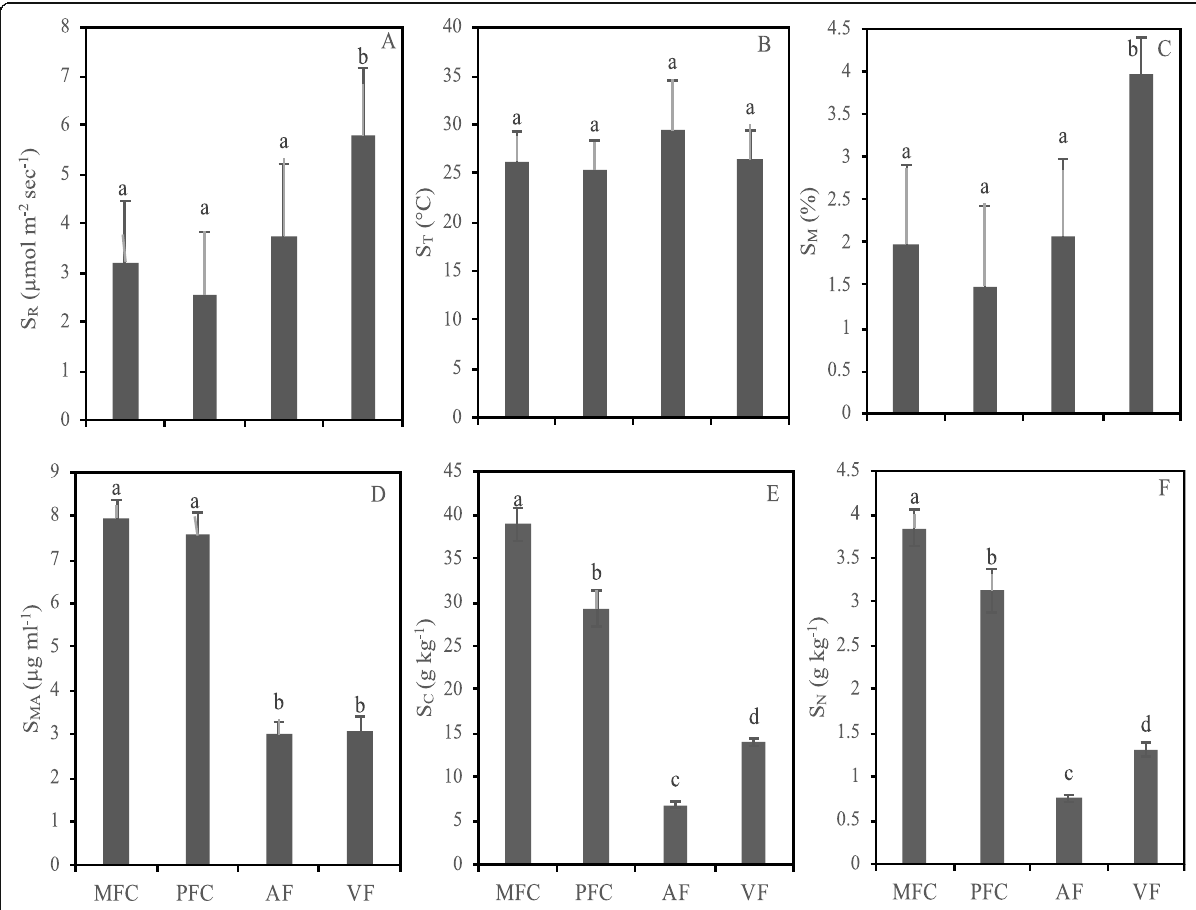
Fig. 3 Annual spatial variations of soil respiration (S R ) and environmental factors among land uses. Mean annual S R soil respiration ( a ), S T soil temperature (at 10 cm depth) ( b ), S M soil moisture ( c ), S MA soil microbial activity ( d ), S C soil carbon ( e ), and S N soil nitrogen ( f ) of PFC Prosopis juliflora forest cover, MFC mixed forest cover, AF agriculture field and VF vegetable field in a semi-arid area. Standard error of each mean is represented over each bar. Different letters denote significant ( P < 0.05) differences among the four land uses sites (Tukey test after one-way